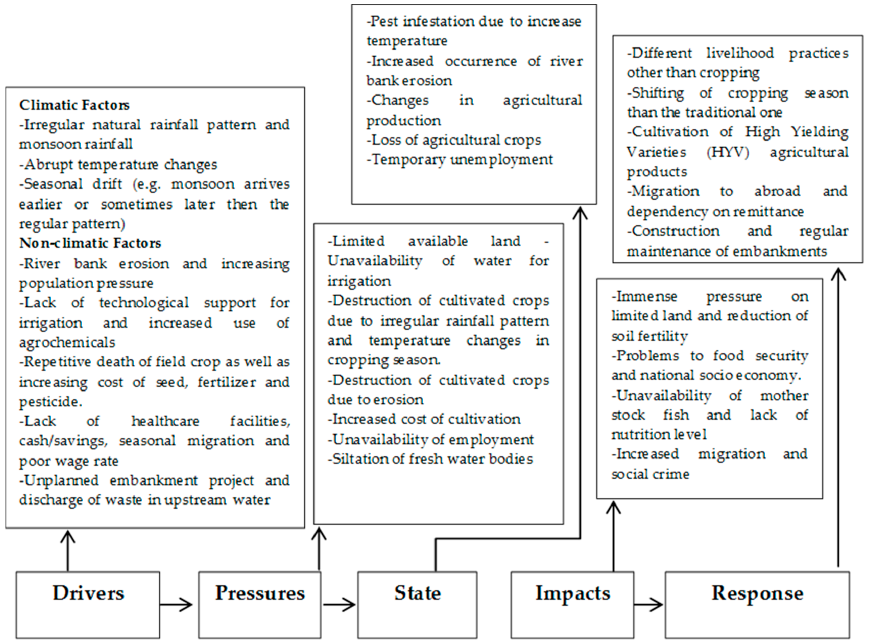
Figure 8. Assessment of vulnerability by applying the DPSIR framework. Table 3. Current risk and vulnerabilities of the study area.